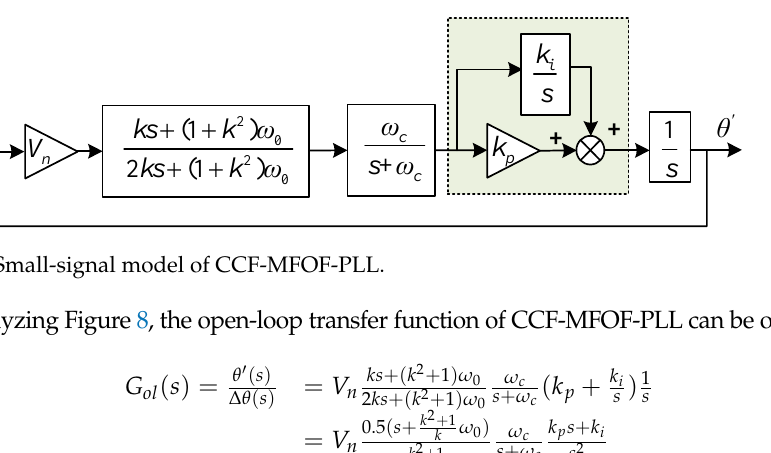
. Figure 7. Bode plot of MFOF before and after improving: ( a ) bode plot of ( ) Q s ; ( b ) bode plot of ( ) Q s  Figure 7. Bode plot of MFOF before and after improving: ( a ) bode plot of Q ( s ) ; ( b ) bode plot of Q ′ ( s ) . .